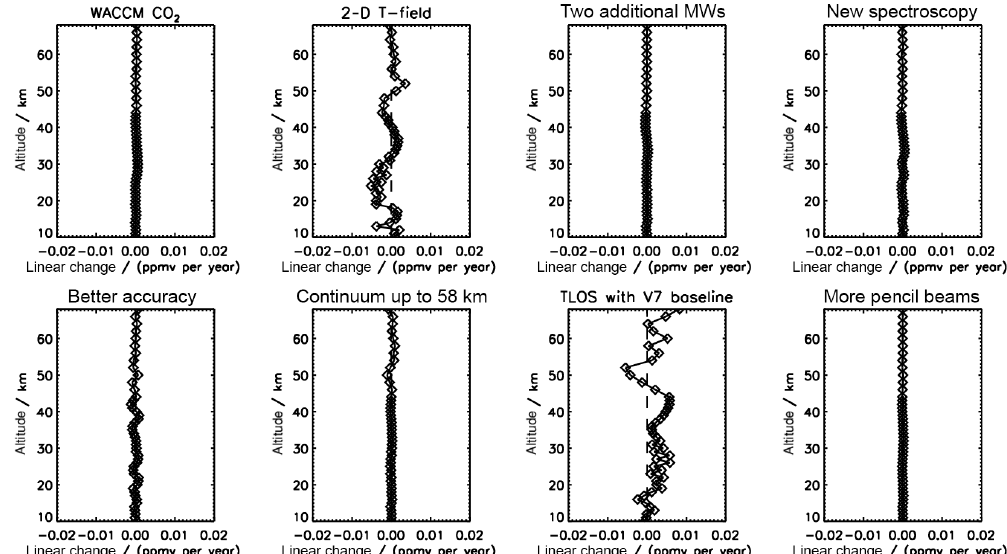
Figure 2. Sensitivity study: how different changes in retrieval setup affect the ozone retrieval. For each change, we show the linear term of differences of ozone retrieved from v7 spectra, using the new retrieval setup and the previous retrieval setup. Each panel corresponds to a retrieval setting for which only one parameter (which is stated in the title of the panel) is changed, and all other parameters remain unchanged.